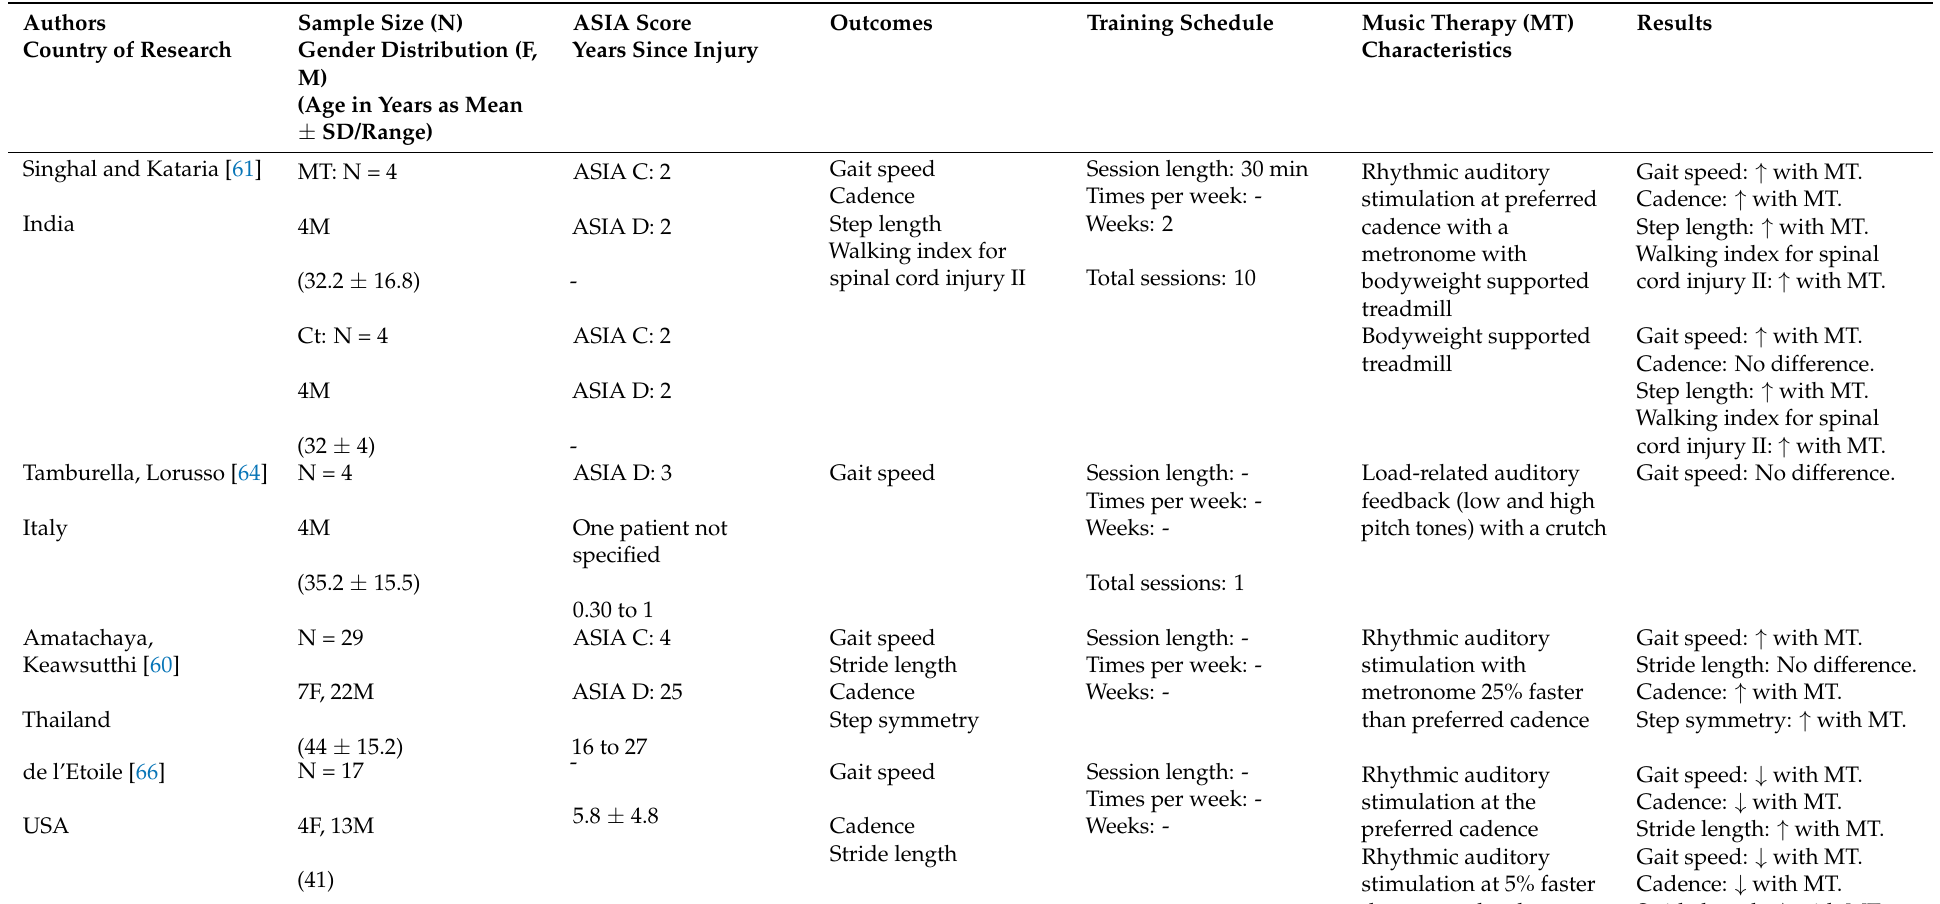
Table 2. Details of studies evaluating individuals with spinal cord